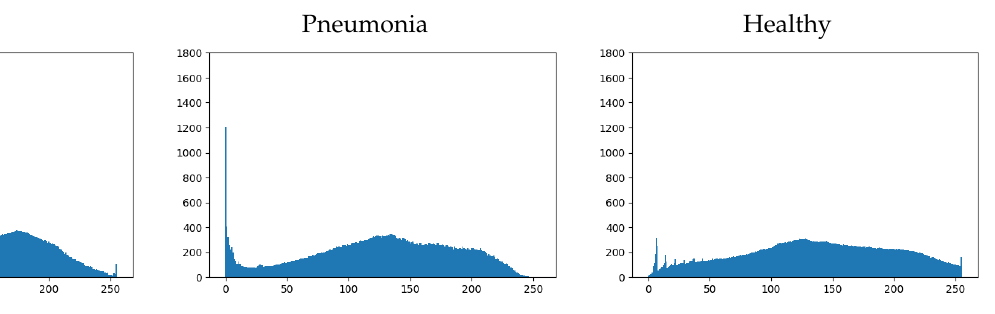
Figure 5. Mean histogram for each